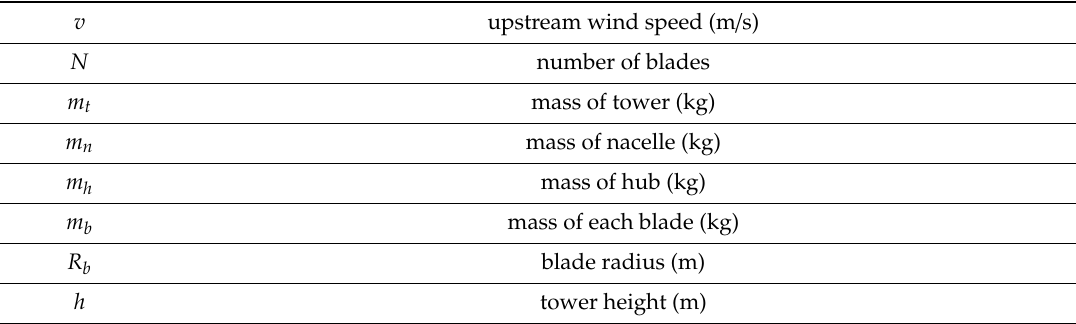
Table 1. Parameters